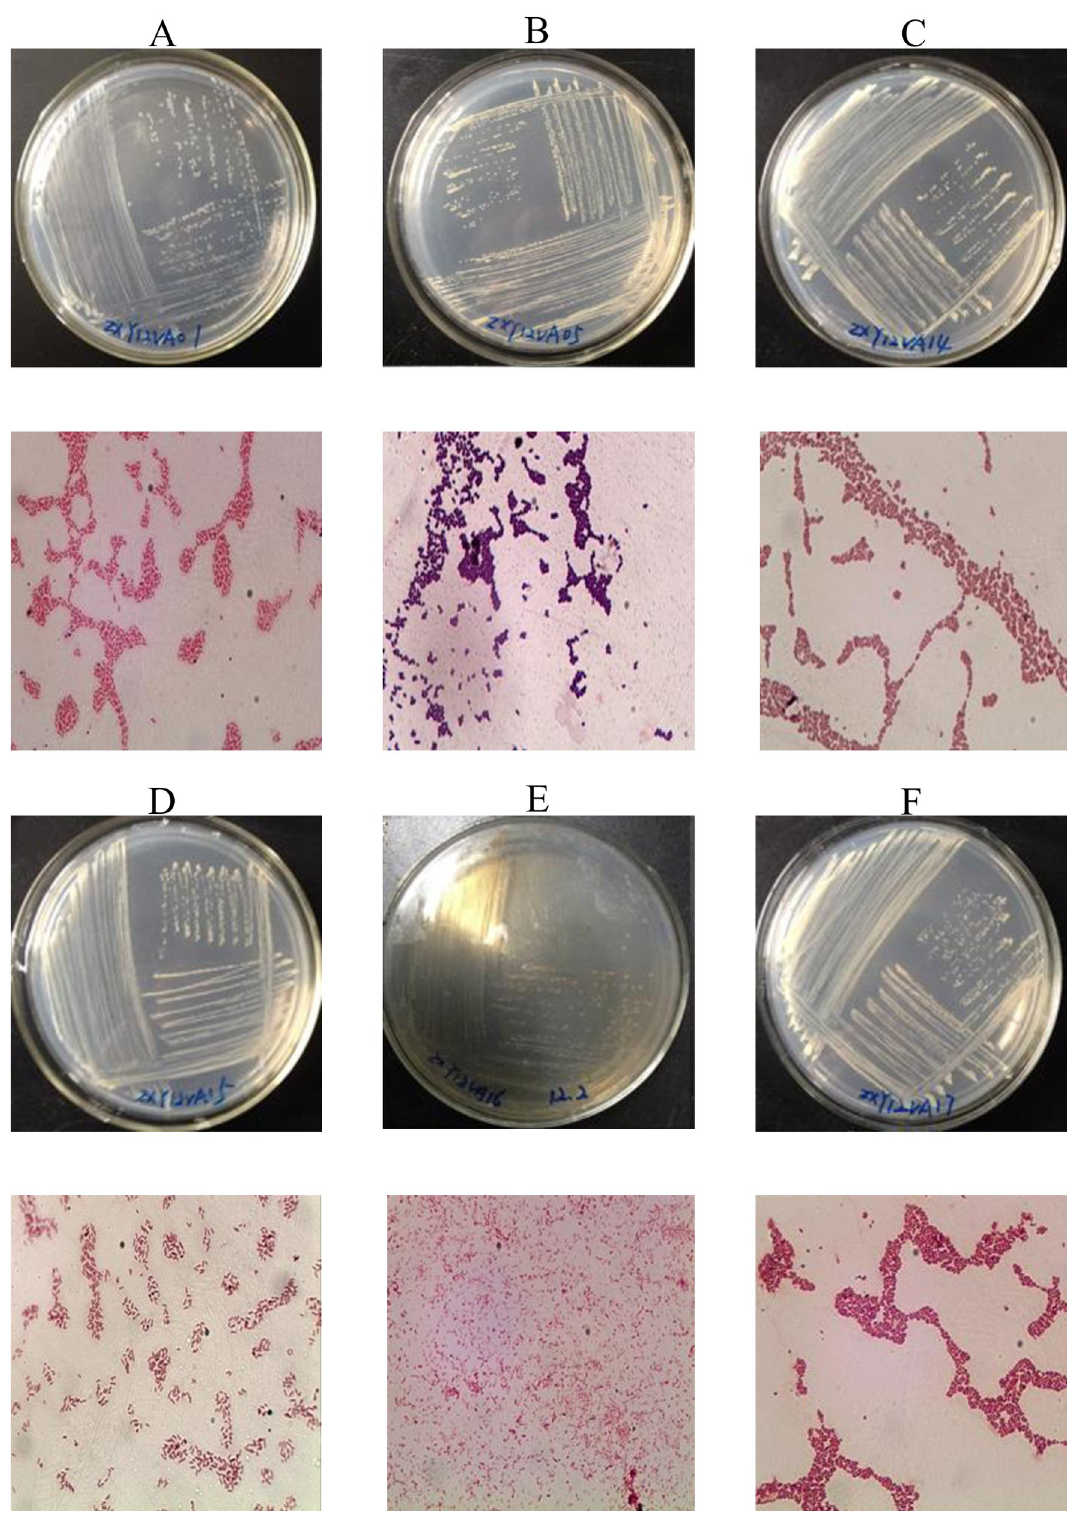
Fig 1. Gram stain of isolates ZXY12VA01 (A), ZXY12VA05 (B), ZXY12VA14 (C), ZXY12VA15 (D), ZXY12VA16 (E), ZXY12VA17 (F).